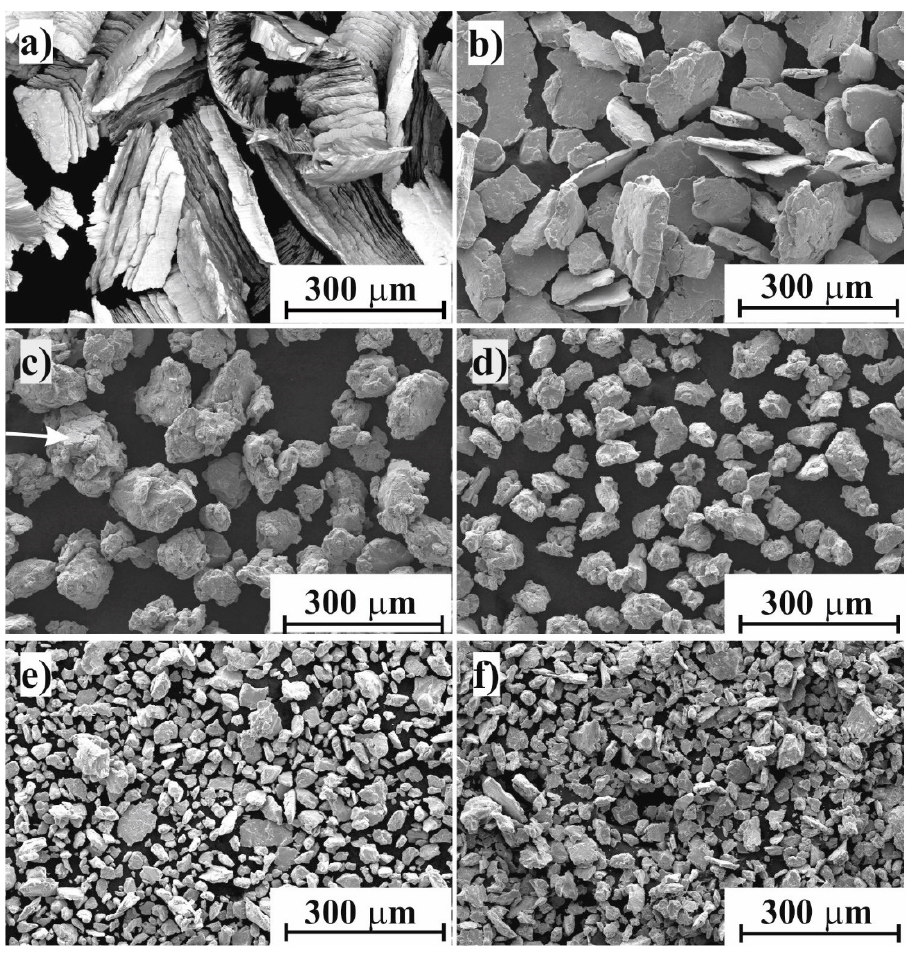
Figure 1. Scanning electron microscopy (SEM) images for the Ti 50 Cu 25 Ni 20 Sn 5 alloy milled for different periods: ( a ) the as-received chips and after ( b ) 30 min, ( c ) 60 min, ( d ) 120 min, ( e ) 150 min, and ( f ) 180 min of milling.